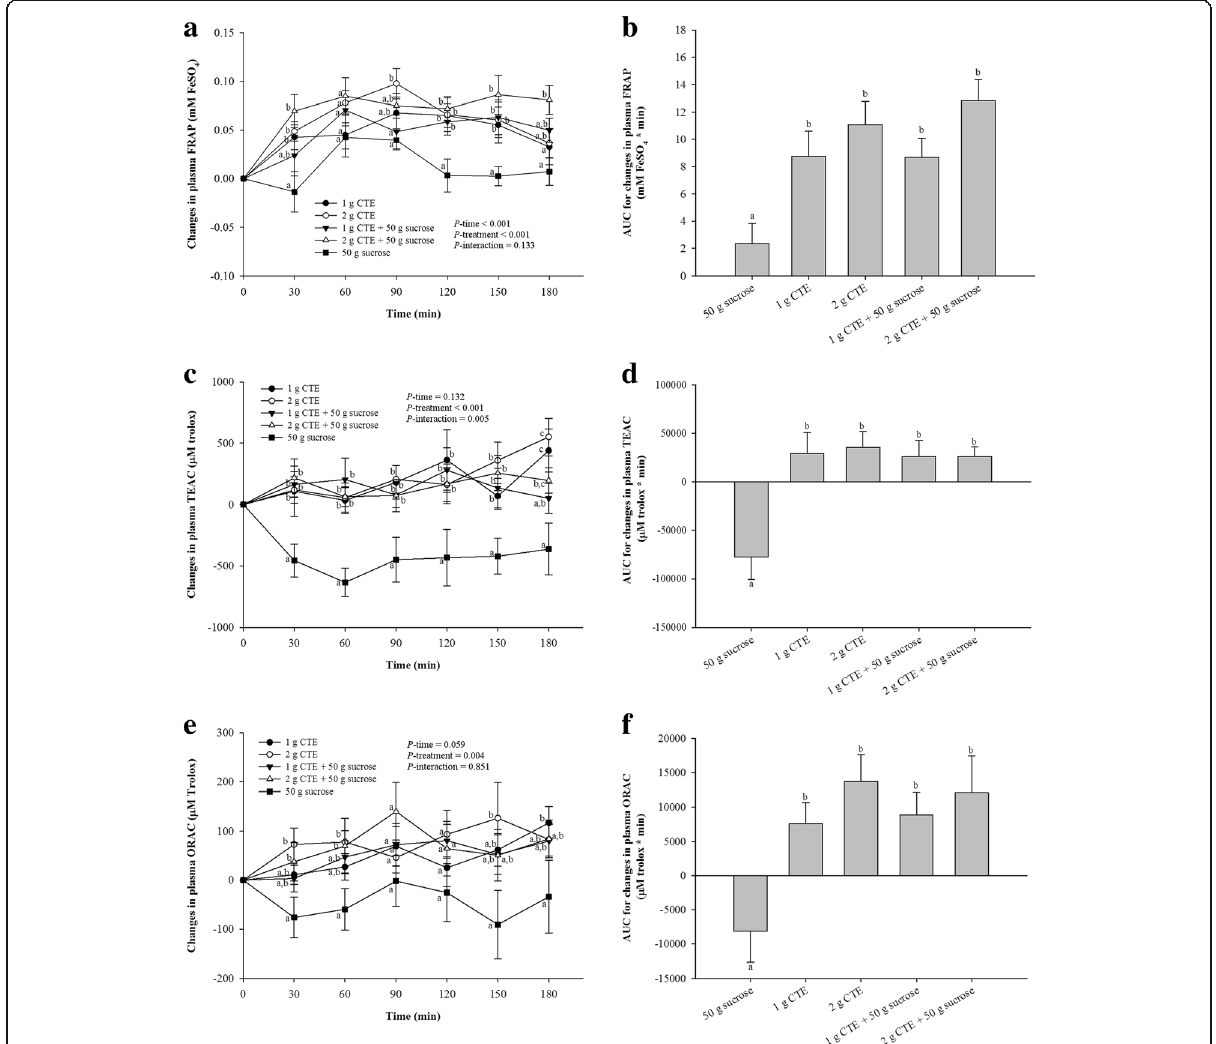
Fig. 5 Postprandial plasma antioxidant capacities of five different beverages. a Changes in FRAP, ( c ) TEAC and ( e ) ORAC concentrations during 180 min of five different beverages; ( b ) FRAP, ( d ) TEAC and ( f ) ORAC changes area under the curves (AUCs) of five different beverages. Values are means ± SEM, n = 15. Different letters are significantly different ( P <